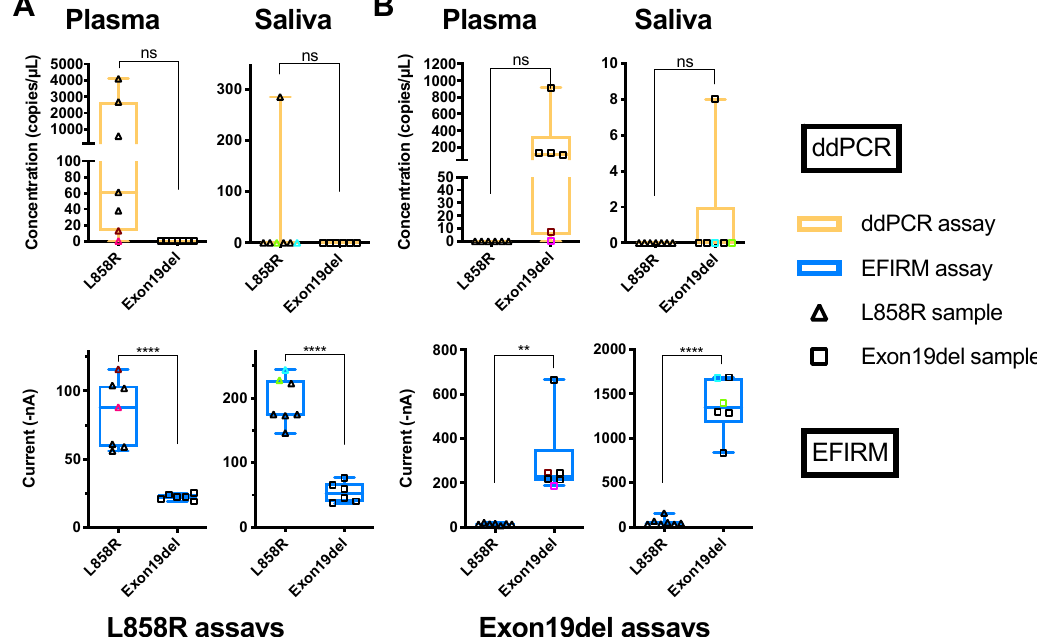
Figure 1. Detection of EGFR mutations in plasma and saliva with ddPCR and EFIRM assays. ( A ) Cell-free DNA was extracted from plasma and saliva samples from NSCLC patients. The ddPCR assay for L858R (upper row, orange) was performed with extracted cfDNA from plasma (left column) and saliva (right column). The EFIRM L858R assay was (lower row, blue) tested with different biofluid samples directly. ( B ) Results of exon 19-del detection with extracted cfDNA from different biofluids using ddPCR and EFIRM are shown in the upper row and lower row, respectively. Samples with exon 19-del mutation and L858R in EGFR gene identified by tissue genotyping are labeled as empty square and empty triangles, respectively. The samples with the lowest and the second-lowest copy numbers in ddPCR measurement are labeled with colors in each biofluid. The unpaired t-tests of different groups in each test were performed. ns means not significant, * means p < 0.05, ** means p < 0.01, **** means p < 0.0001.